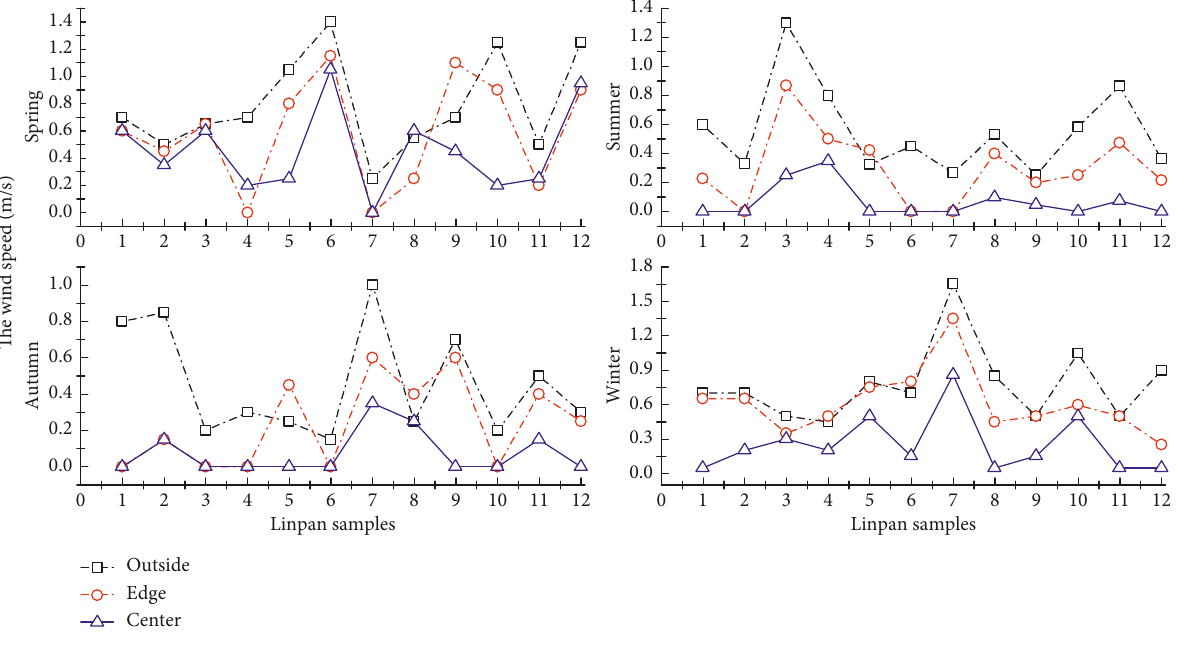
Figure 9: The seasonal wind speed of Linpan samples. Table 5: Pearson correlation analysis between Linpan size and seasonal micrometeorology parameters.